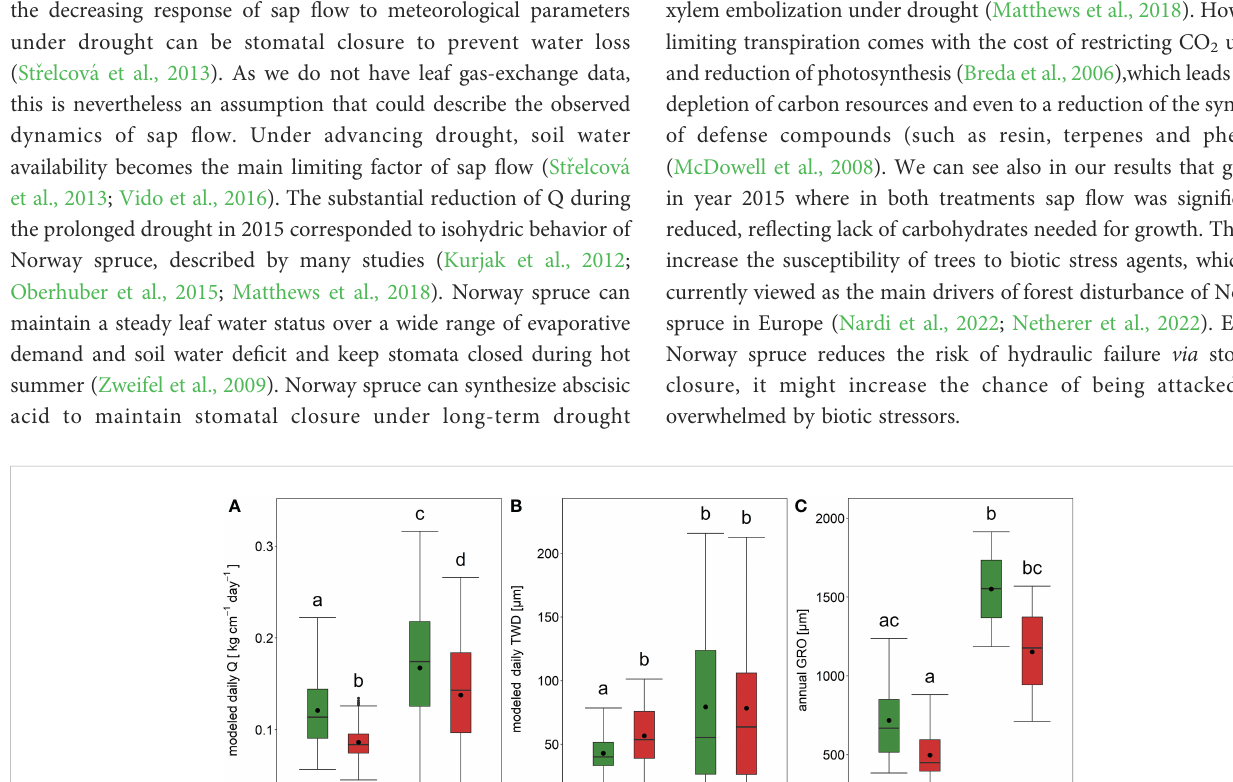
treatment interaction ns The ns means non-statistically signi fi cant. Df refers to degrees offreedom, p-value to signi fi cance of the test, F stat to F statistics, two-way ANOVA to Analysis of Variance, two-way ANOVA of ART to Analysis of Variance of Aligned Rank Transformed Data.